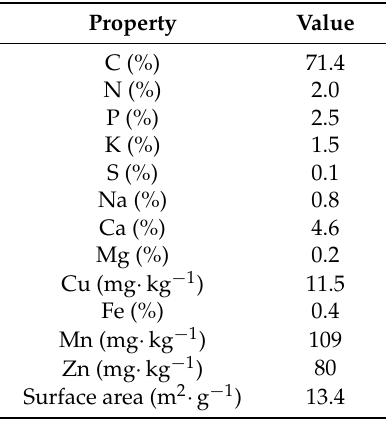
Table 3. Basic characteristics of oat hull biochar used in the field